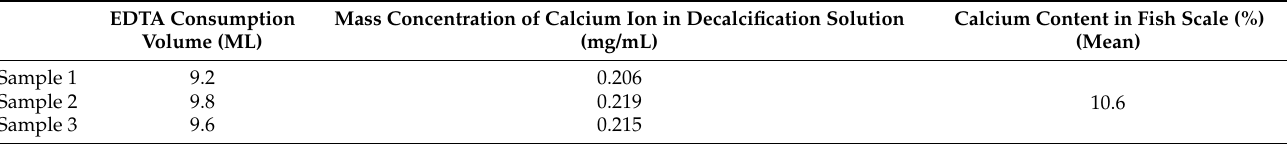
Table 1. Determination and calculation results of calcium content in fish scales.